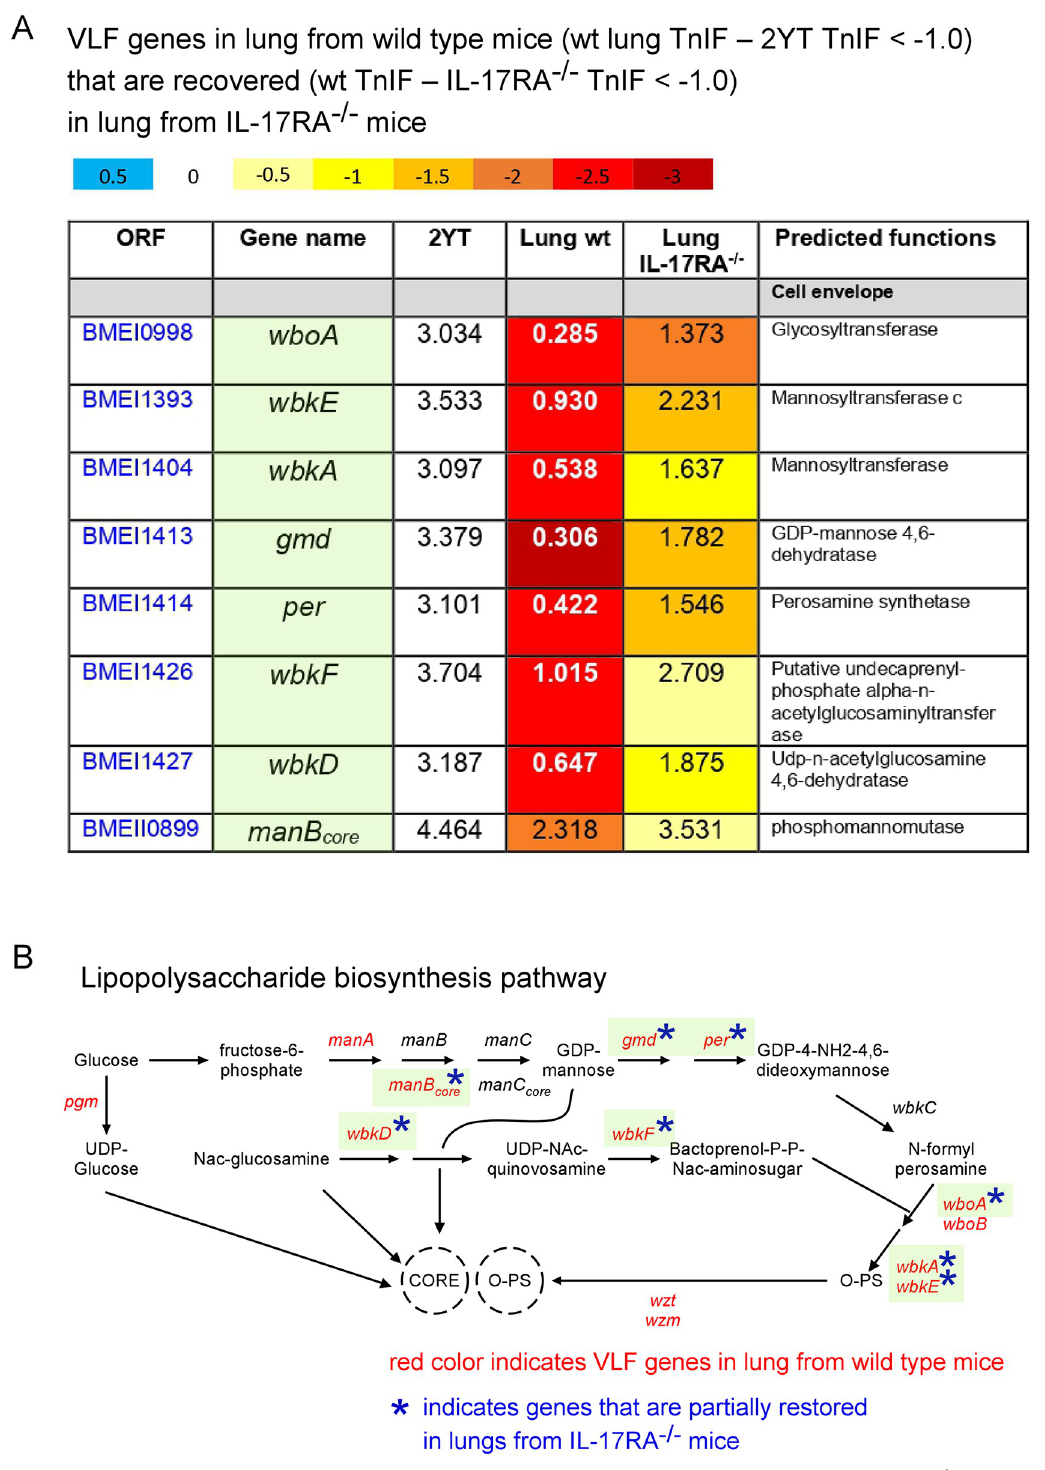
Fig 10. Comparison of B . melitensis genes required for optimal multiplication in lungs of wild-type and IL-17RA -/- mice. A . List of VLF genes in lungs of wild-type mice ( < -1.0 Δ TnIF) that are recovered ( > 1.0) in lungs of IL-17RA -/- mice associated with their TnIF values in the CTRL 2YT and lung from wild type and IL-17RA -/- mice conditions, as well as predicted function. B . Schematic representation of the lipopolysaccharide biosynthesis pathway of Brucella specifying the genes that become partially dispensable in the IL-17RA -/- mice condition (adapted from the KEGG PATHWAY database, https://www.genome.jp/kegg/ pathway.html). https://doi.org/10.1371/journal.ppat.1010621.g010 PLOS Pathogens| https://doi.org/10.1371/journal.ppat.1010621 June 30,